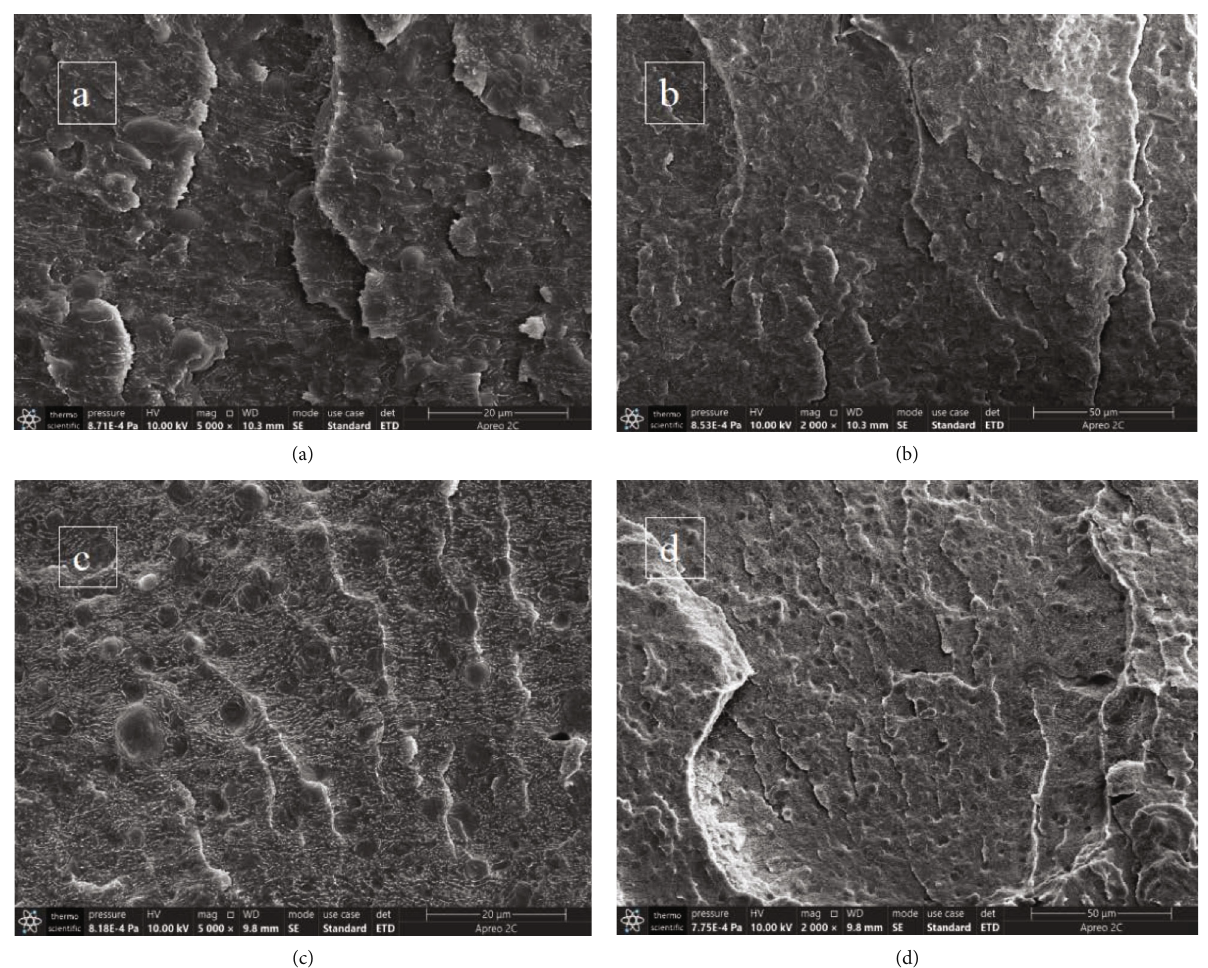
Figure 7: SEM photographs of PP 5000 (c) and 2000